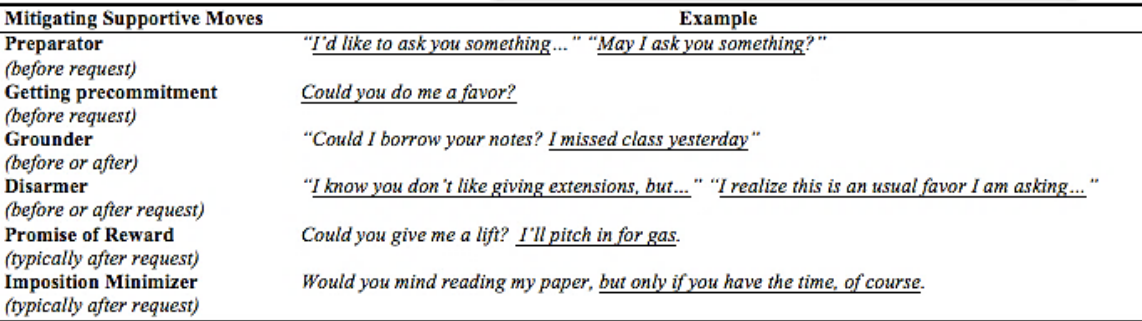
Supportive Moves – External Modification -